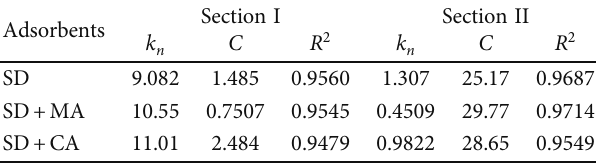
Table 5: Di ff usion parameters in particles of adsorption of boron chloride on SD, SD +MA, and SD +CA.